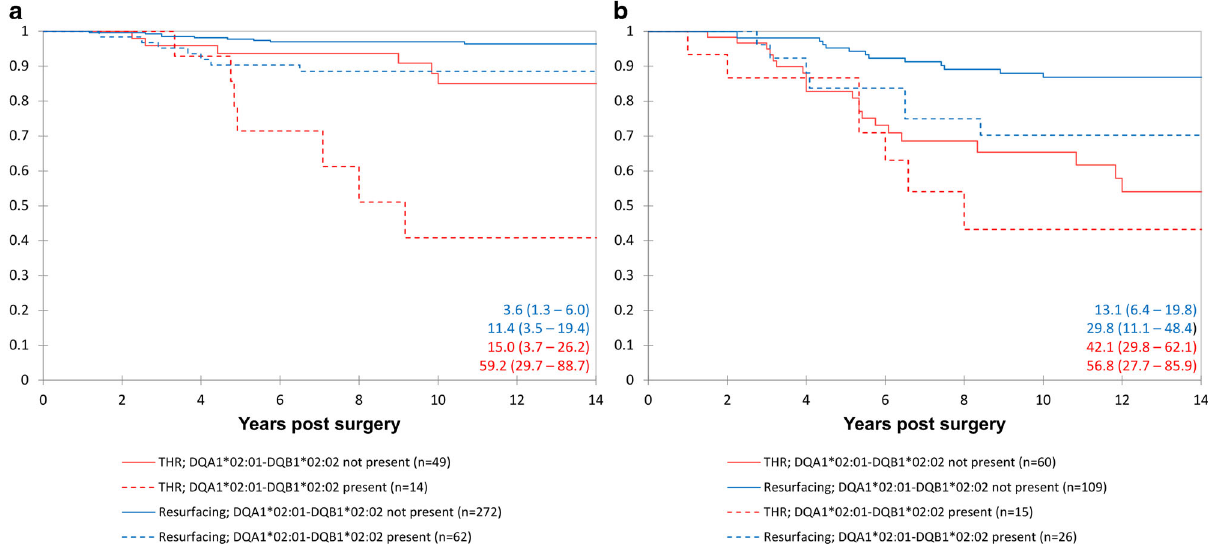
Fig. 6 Kaplan Meier survival analysis of the hip resurfacing patients. a Male patients. b female patients. Failure de fi ned as revision secondary to ALVAL (mild, moderate, or severe). Patients were subdivided according to blood ion concentrations: ( “ low ions ” (Co < 2; Cr < 4) and “ elevated ions ” (Co ≤ 2 or Cr ≤ 4 µ g/l)) and genotype (presence or absence of DQA1*02:01-DQB1*02:02). Failure rates at 12 years are shown on the bottom right of the charts (with 95% con fi dence intervals).